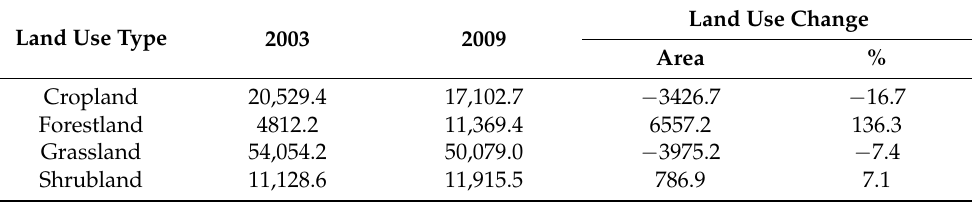
Figure 7. Trend in mean annual GPP in the typical area during 2000–2012.